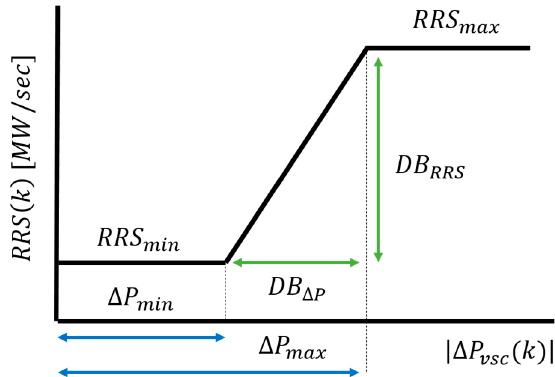
Figure 5. Different RRSs of ramp-rate control; DB: difference between.